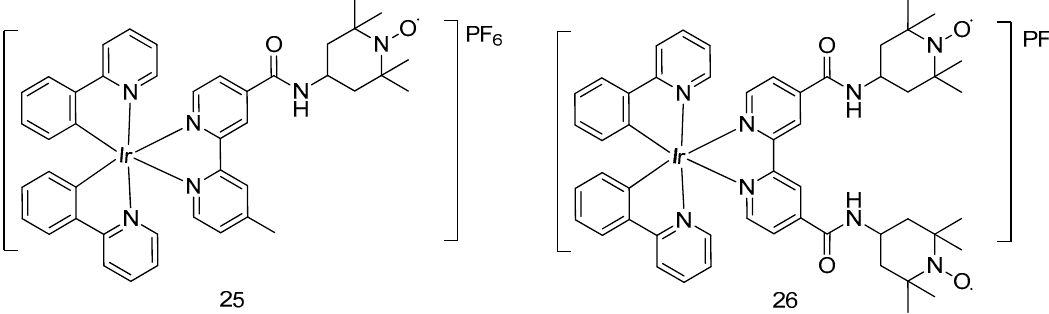
Figure 8 . Octahedral iridium(III) compounds with 2,2,6,6-tetramethylpiperidine-N-oxyl (TEMPO) Figure ligands.